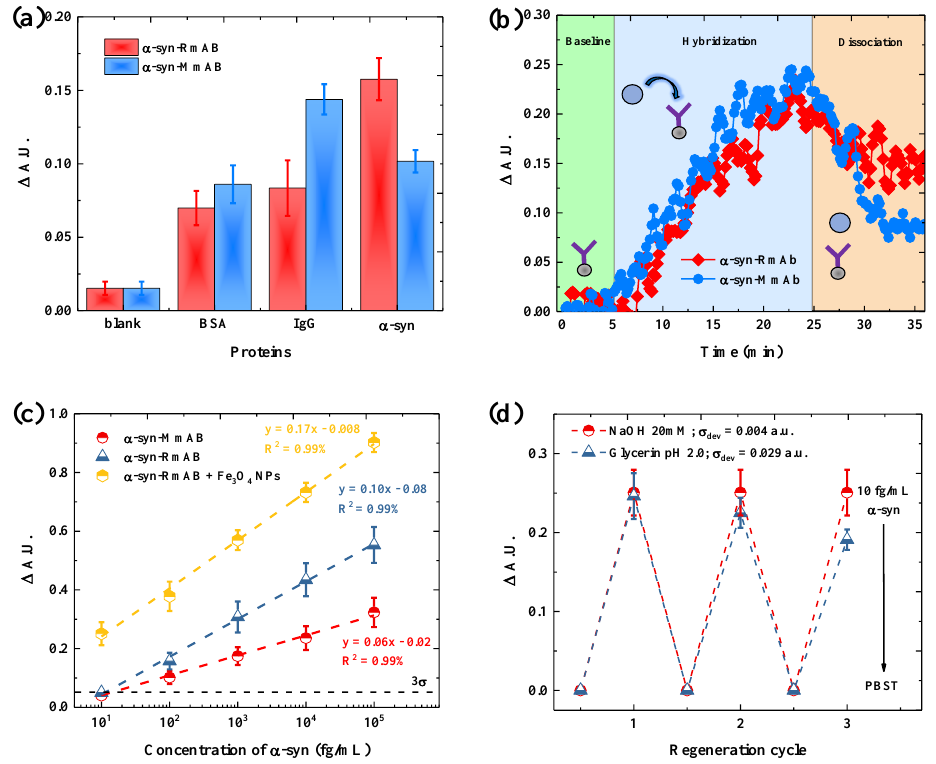
Figure 3. Evaluation of ( a ) selectivity and ( b ) binding affinity of α -syn-RmAb and α -syn-MmAb for detection of 100fg/mL α -syn. ( c ) Correlation between SPR signal and α -syn concentrations for without Fe 3 O 4 NPs ( α -syn-RmAb or α -syn-MmA) and with Fe 3 O 4 NPs enhancement. ( d ) Investiga- tion of reproducibility of α -syn-RmAb/Fe 3 O 4 NPs/SAM/Au sensor chips. The sensor chips was regenerated using a glycerin solution with pH 2.0 (blue dots color) and 20 mM NaOH with pH 9.0 (red dots color). Note: the error bars represent the standard deviation of the three replicated